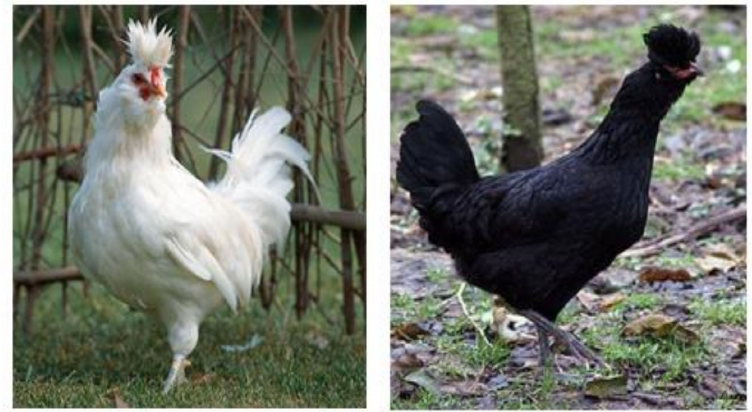
Figure 1. Specimens of Polverara White (PW) and Polverara Black (PB)